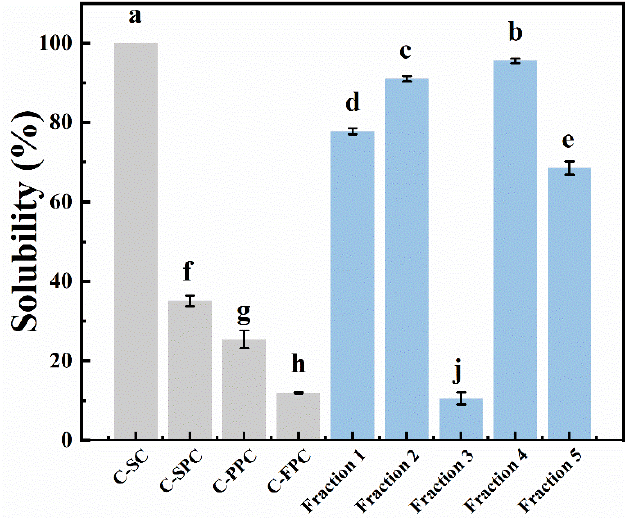
Figure 4. Solubility of flaxseed protein-polysaccharide natural fractions, C-SC, C-SPC, C-PPC, and C-FPC at pH 7.0. Comparisons were performed between values of the same serious and those without same letter(s) differed significantly at p < 0.05.